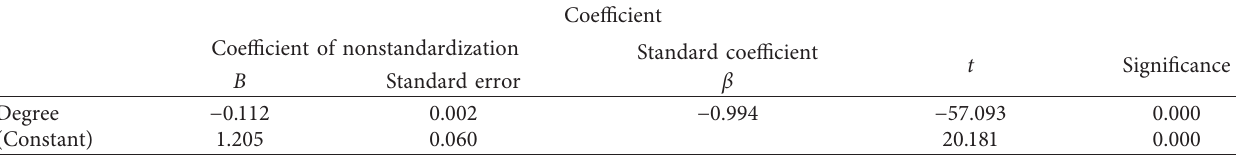
Table 1: Summary of statistical